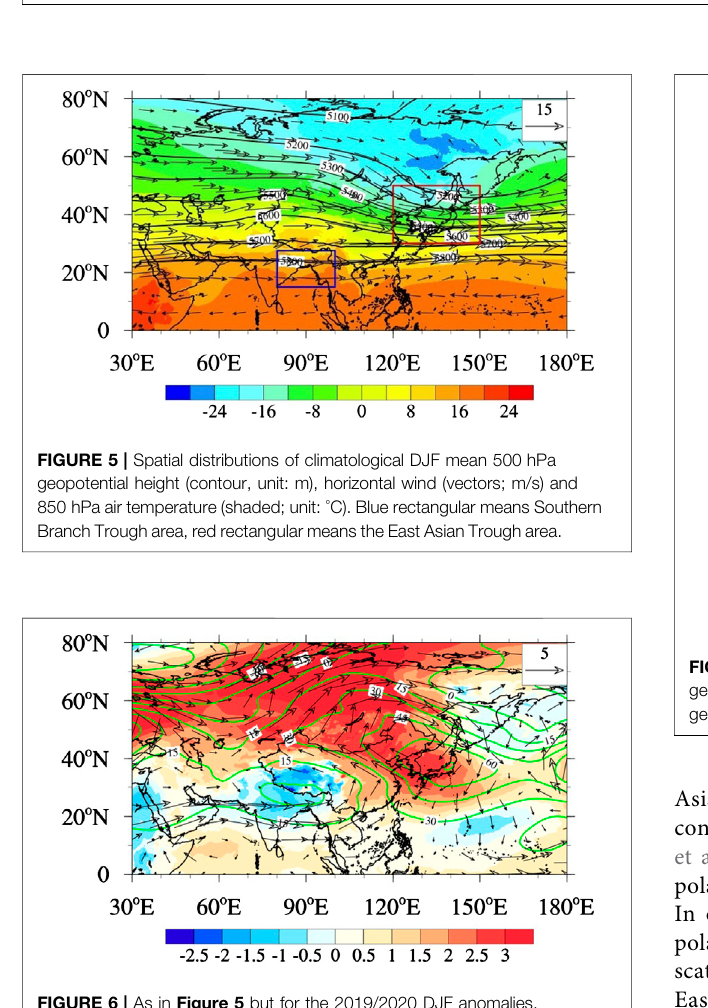
FIGURE 6 | As in Figure 5 but for the 2019/2020 DJF anomalies.